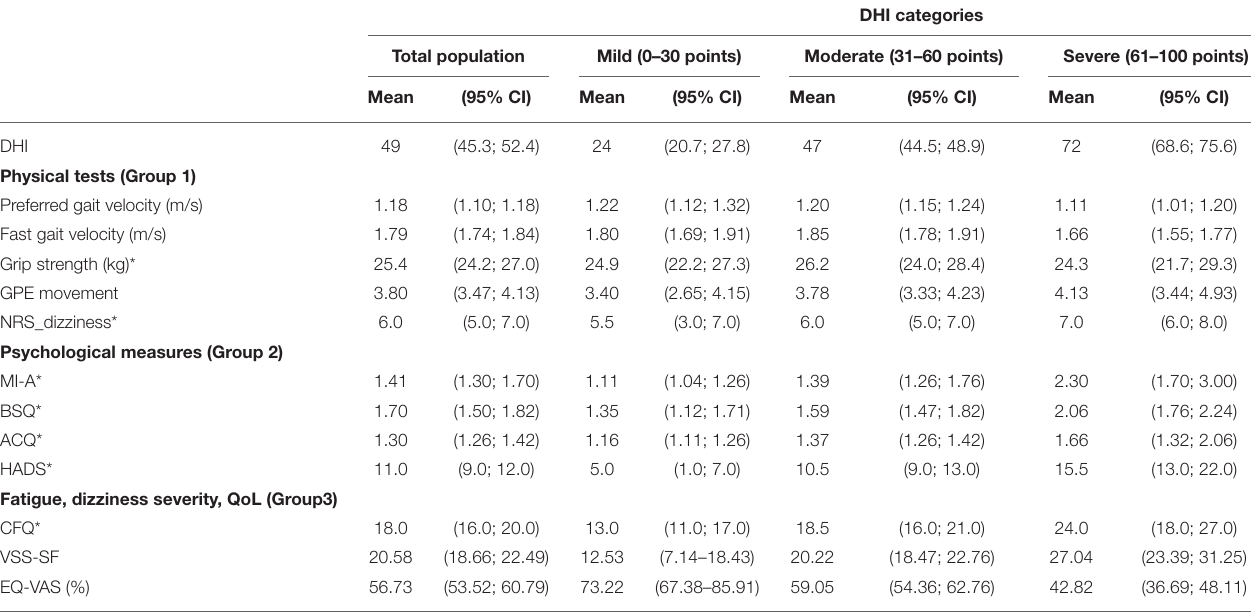
TABLE 2 | Physical test (Group 1) and self-reported psychological measures (Group 2), and fatigue, dizziness severity and quality of life (Group 3) among participants with persistent dizziness, presented for the total population, and categorized into three levels of severity of the Dizziness Handicap Inventory